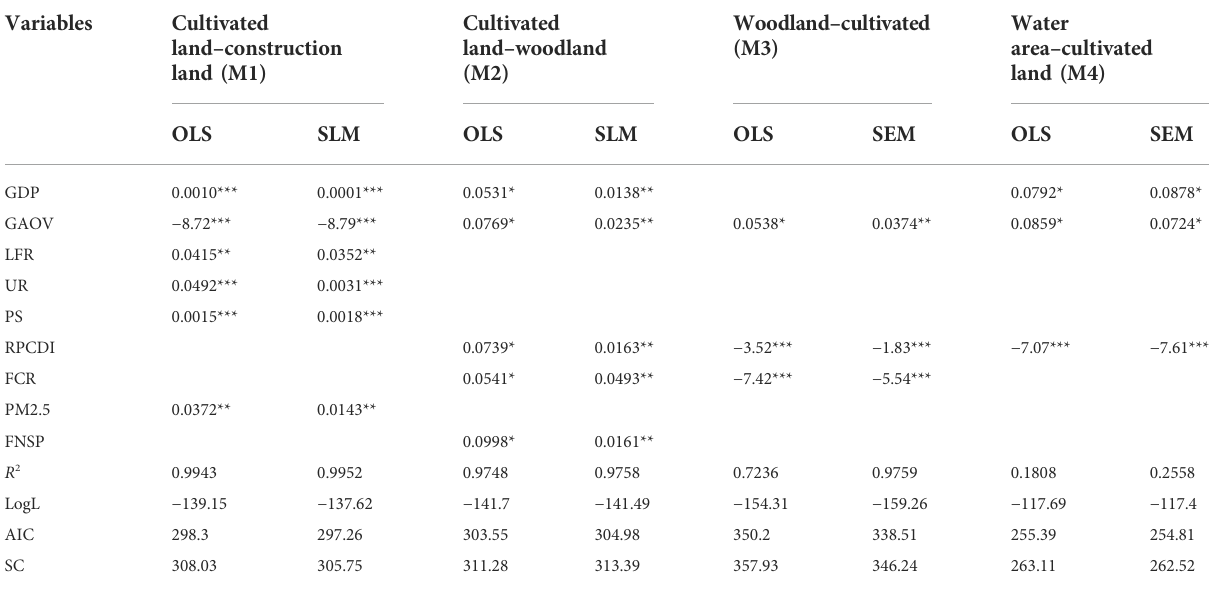
TABLE 6 Factors in fl uencing land use transitions in the study area, 2000 – 2010.